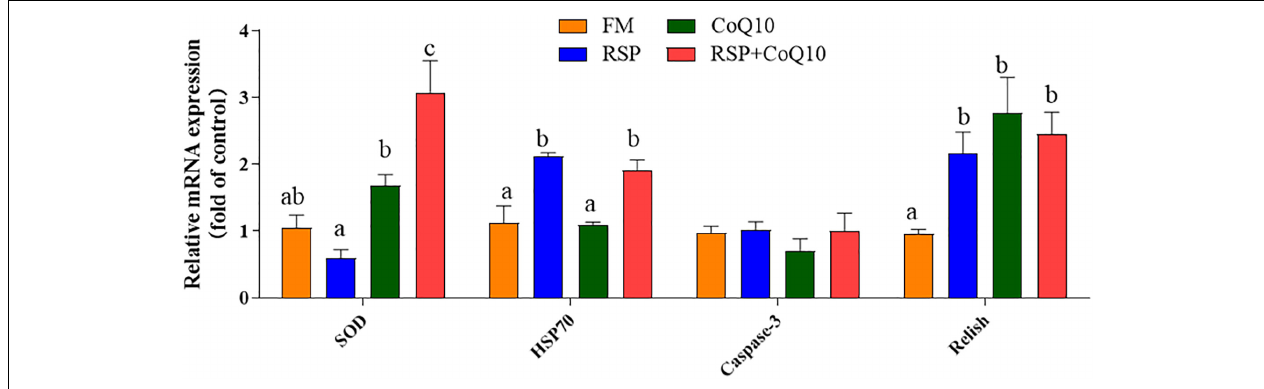
FIGURE 6 | Relative expression of immune-related and antioxidant-related genes in hepatopancreas of shrimp fed with four diet treatments after low salinity stress. Results are mean ± SEM ( n = 3). The column with different superscripts manifests significant differences ( P < 0.05). HSP70 , heat shock protein 70; SOD , superoxide